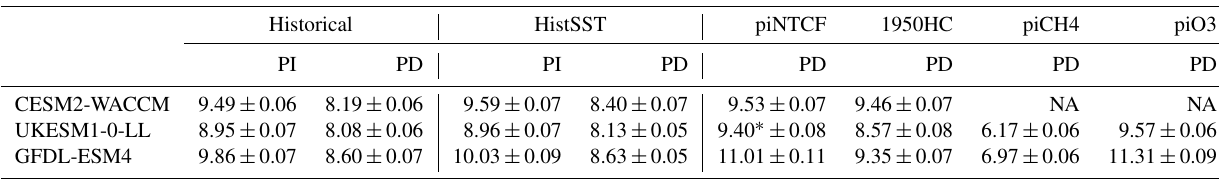
Figure 3. First column: zonal mean (latitude–pressure, hPa) cross sections for OH concentration (10 5 molec.cm − 3 ) averaged over the period 2005–2014 (PD) for the histSST simulations. Rows show results for CESM2-WACCM, GFDL-ESM4, and UKESM1-0-LL. Solid lines indicate the tropopause (PD in black; other in green). Other panels show differences (%) between experiments. Second column: histSST PD minus PI (1850–1859 mean). Third column: histSST minus histSST-piNTCF for PD. Fourth column: histSST minus histSST-1950HC for PD. Table 3. Whole-atmosphere methane chemical (not including soil sink) lifetimes (years). PI refers to the 1850–1859 mean; PD refers to the 2005–2014 mean. Uncertainties are ± 1 standard deviation based on the range of annual